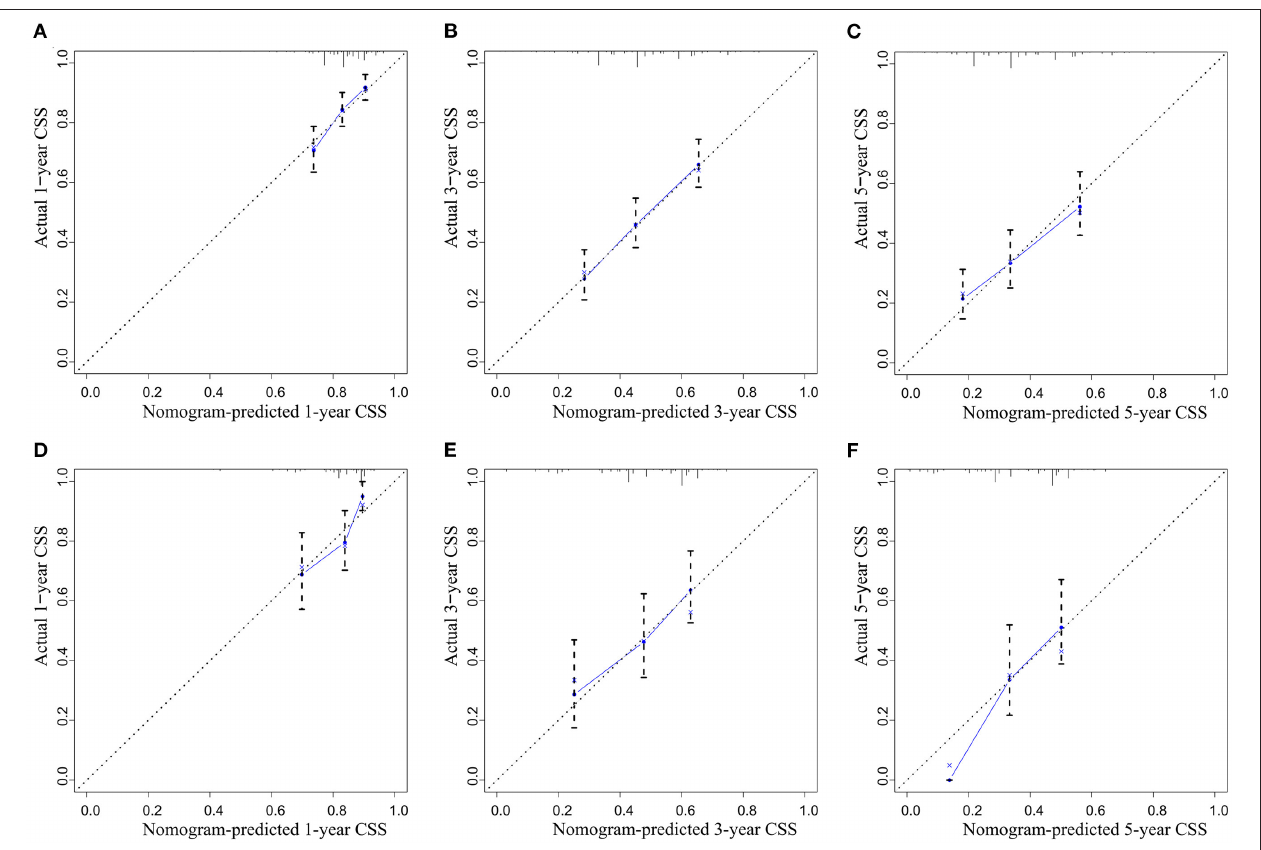
FIGURE 4 | The calibration curve for predicting CSS: (A) at 1 year in the training set; (B) at 3 years in the training set; (C) at 5 years in the training set; (D) at 1 year in the validation set; (E) at 3 years in the validation set; (F) at 5 years in the validation set.